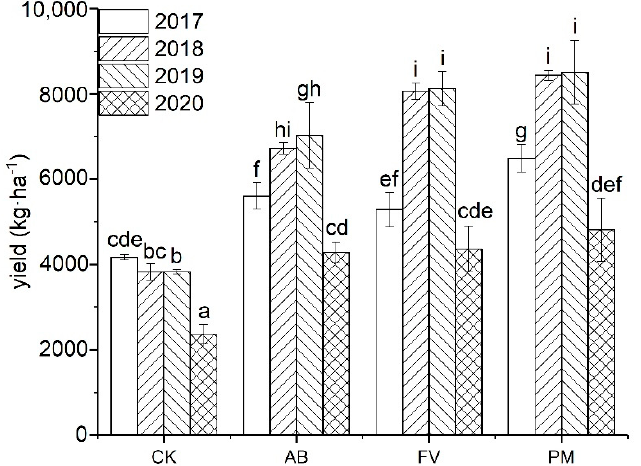
Figure 5. Yield of rice grains by the different fertilizer treatments during the four experimental years. Data are expressed as means ± SD; n = 3. Different letters on data in the same group indicate a significant difference between them at p < 0.05